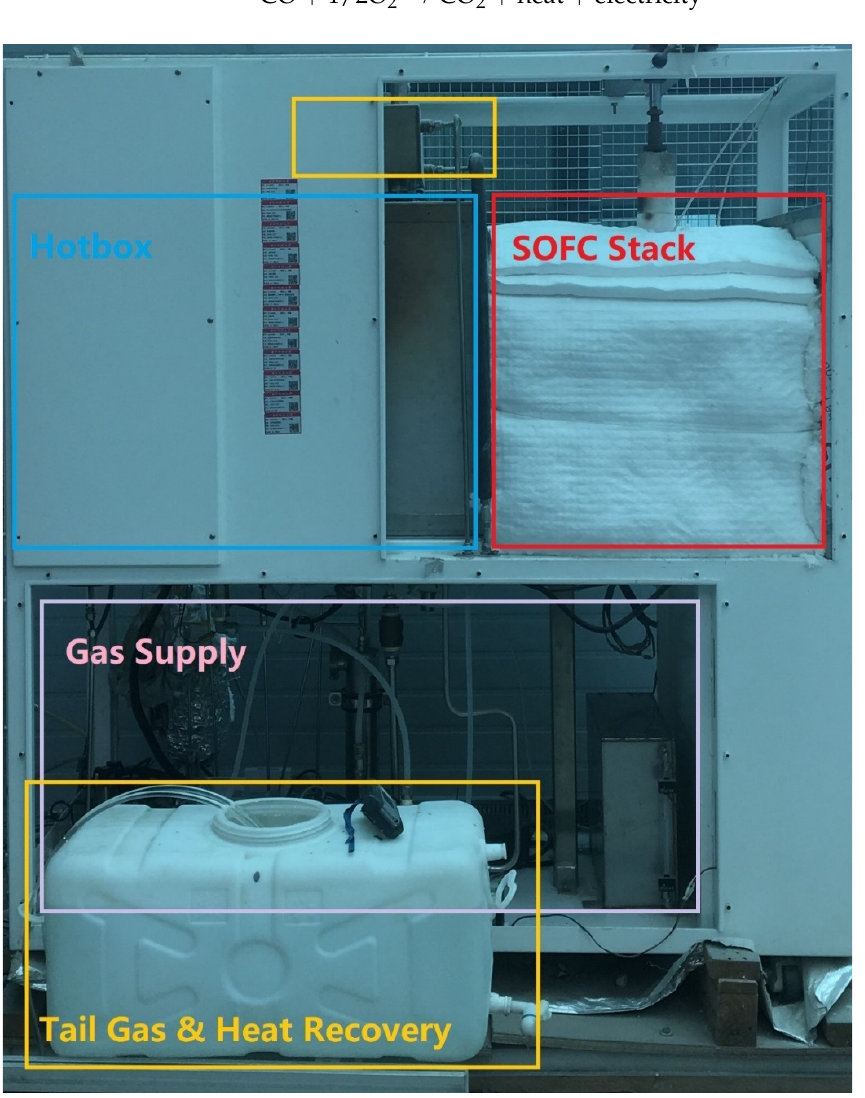
Figure 1. 1 kW SOFC power generation system.